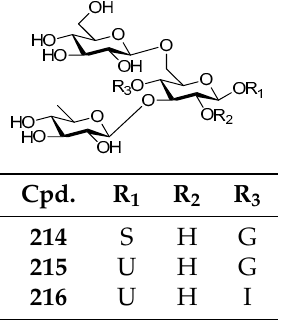
Figure 34. Structures of compounds 214 – 216 .